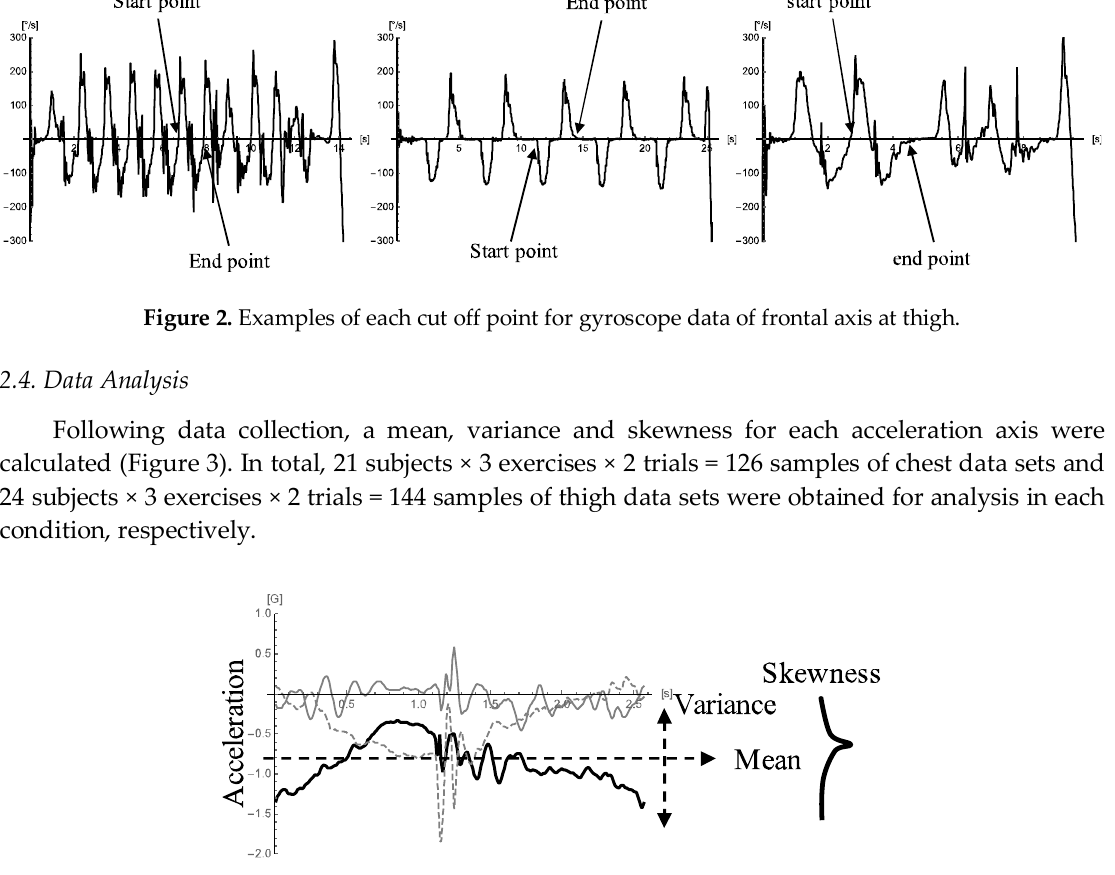
Figure 3. Examples of each calculated